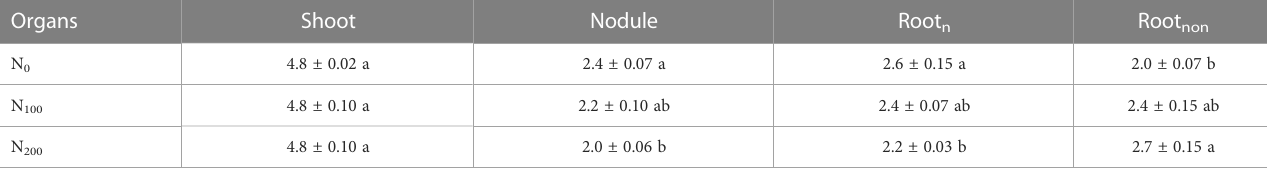
TABLE 2 13 C abundance of dual-root soybean plants (atom%). Organs Shoot